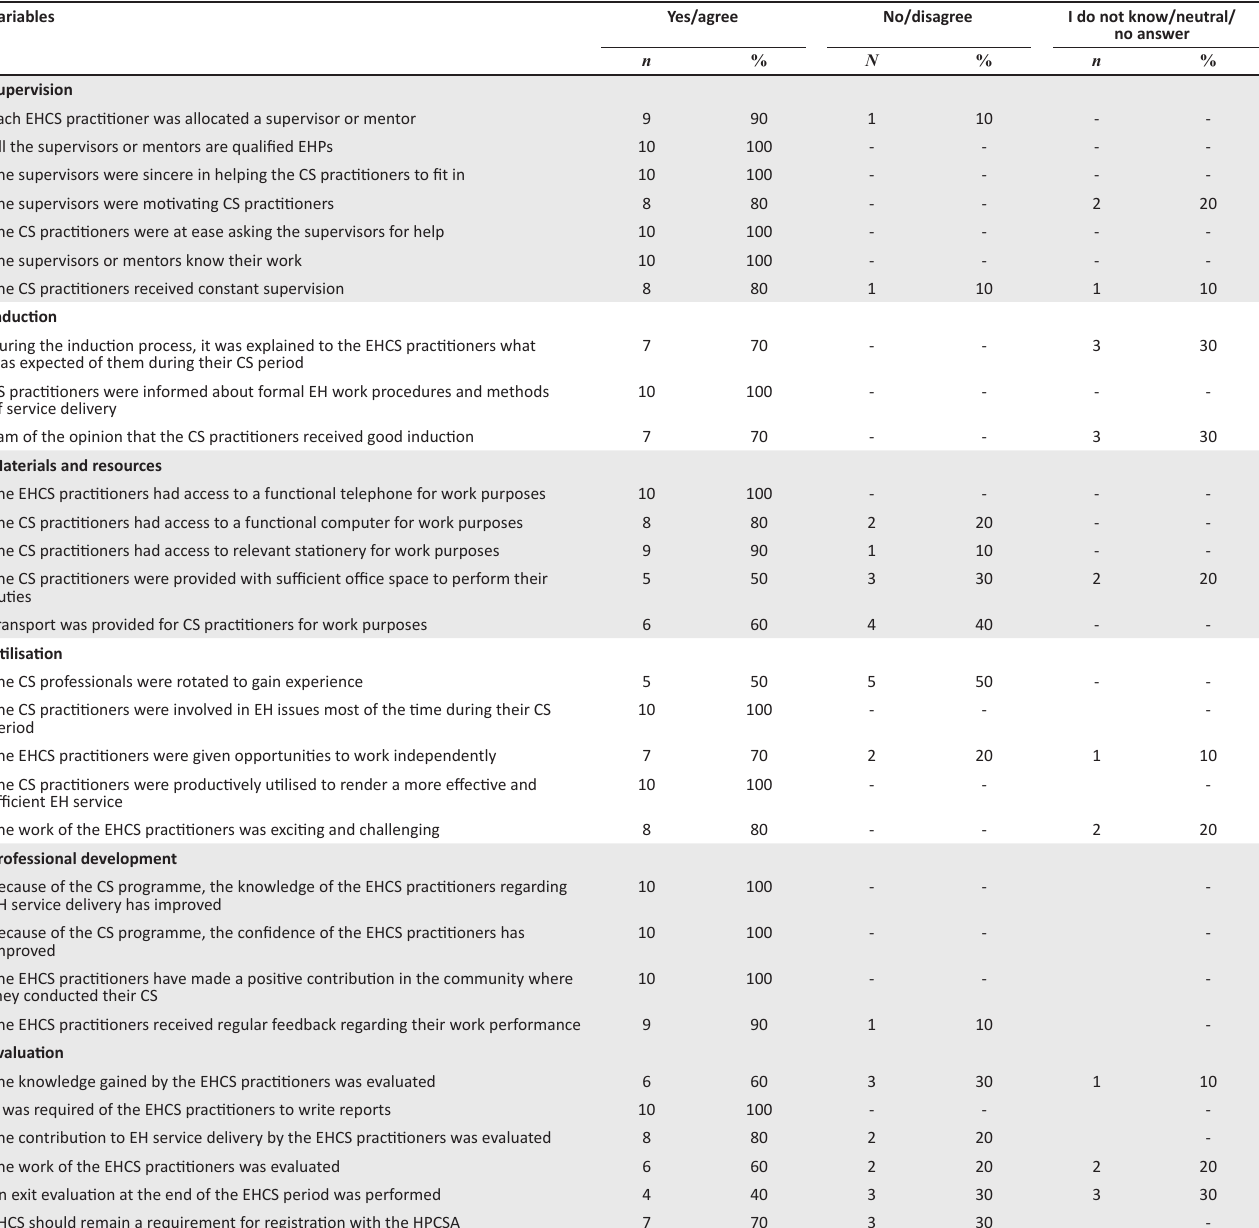
TABLE 2: Experiences of Environmental Health Community Service administrators regarding utilisation and evaluation of Environmental Health Community Service practitioners.